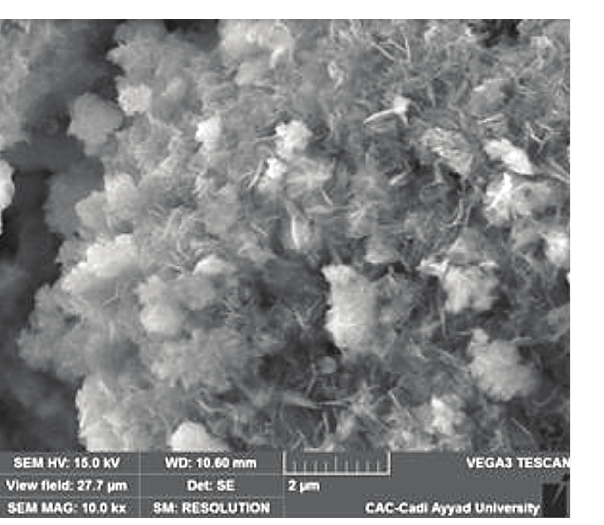
Fig. 9 – SEM photograph of the obtained phase ZnAl-CA af- ter retention (m